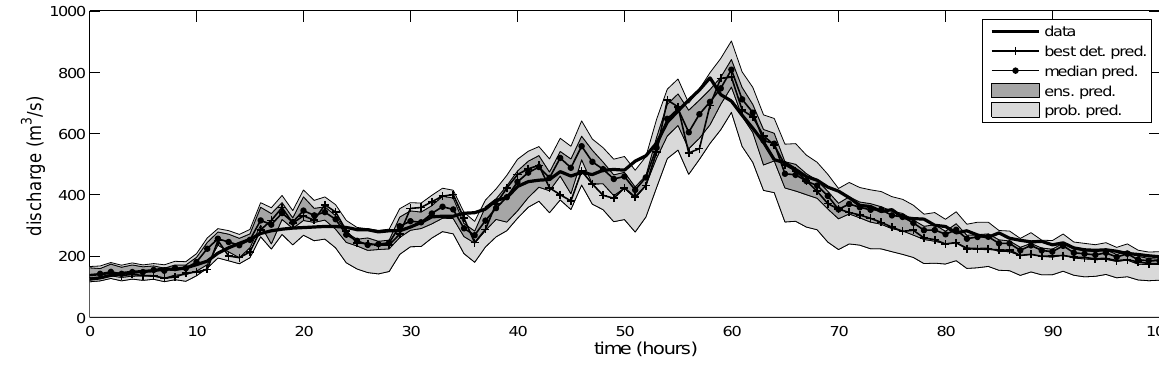
Fig. 3. An example of forecasts of an hourly discharge time series: portion of the testing set with predictions at h = 6h, showing the outcomes of the four prediction methods described in Sect. 4 (see Tamea et al. (2005) and Laio et al. (2007) for all the details).